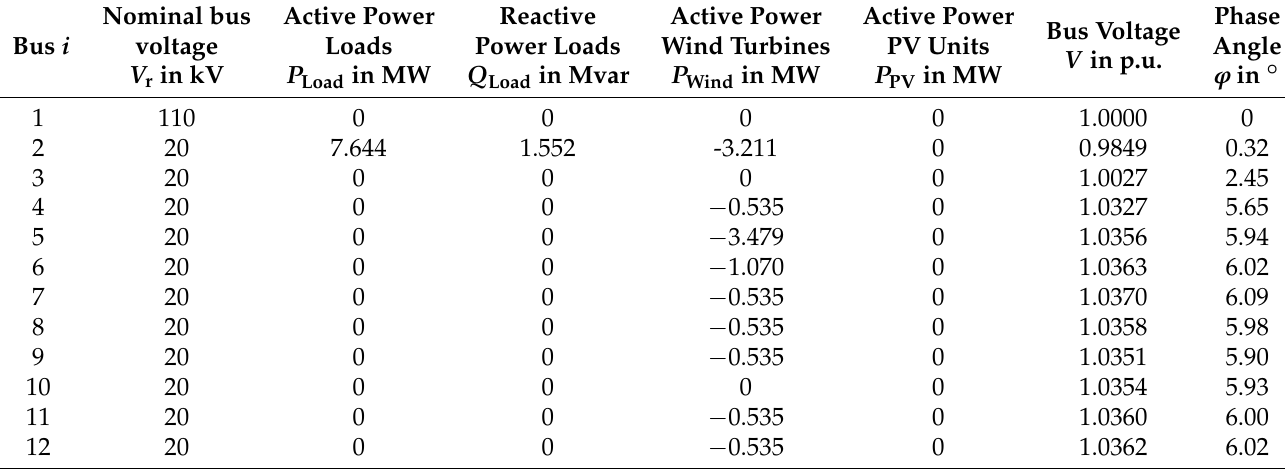
Table A3. Bus information of the Cigré MV benchmark